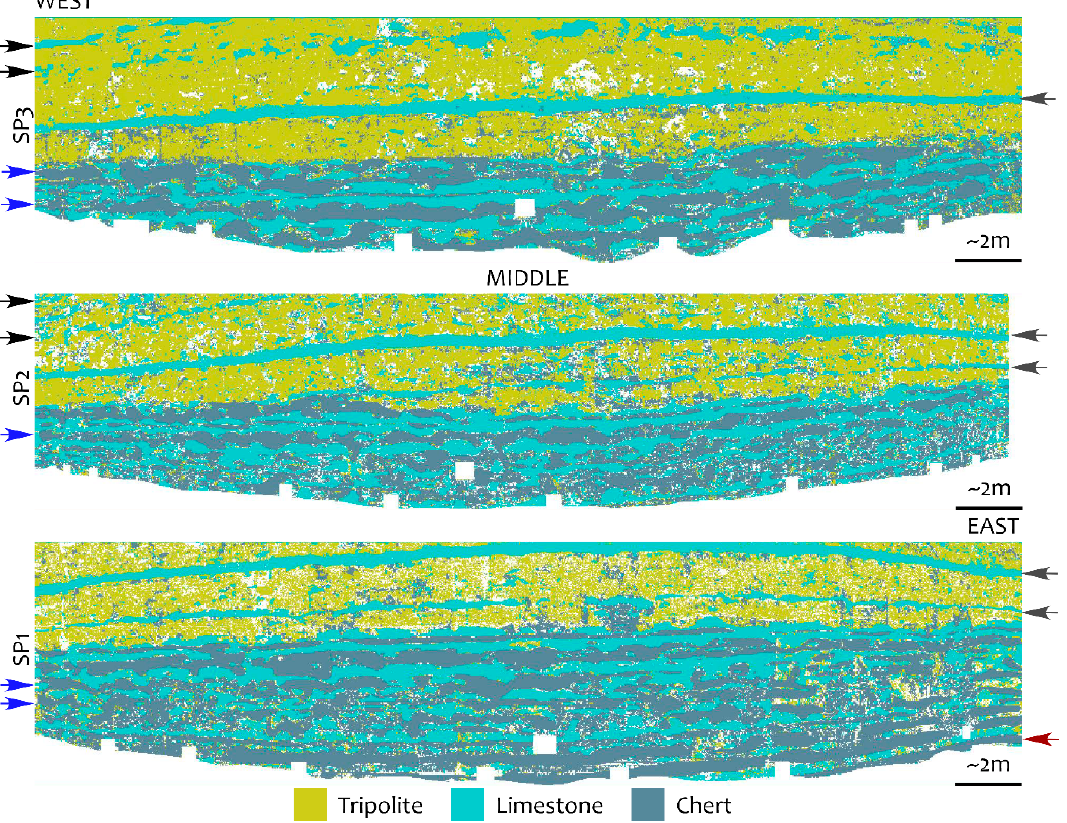
Figure 13. Spectral feature fitting results using ASD-Lab end-member spectra from (SP3) Scan Position 3 to the west, (SP2) Scan Position 2 in the middle, and (SP1) Scan Position 1 to the east of the roadcut. The black arrows show patches of limestone following a linear pattern, the blue arrows show alternating chert and limestone layers with undulating boundaries, the gray arrows show persistent, continuous limestone layers, and the red arrow shows chert and limestone layers with flat boundaries.